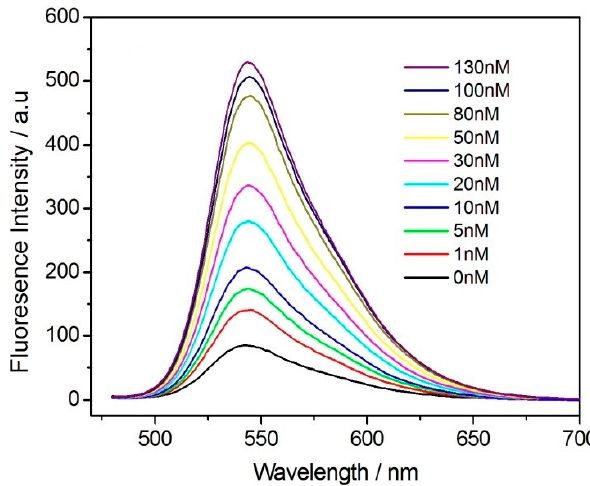
Figure 7. Changing of fluorescence emission spectra of the functionalized Pdots-BHQ-TBA system upon titration by thrombin to serum: 0, 1, 5, 10, 20, 30, 50, 80, 100, and 130 nM in HEPES buffer (20 mM, pH 7.4). Excitation was performed at 455 nm. Table 2. Detection of actual samples ( n =